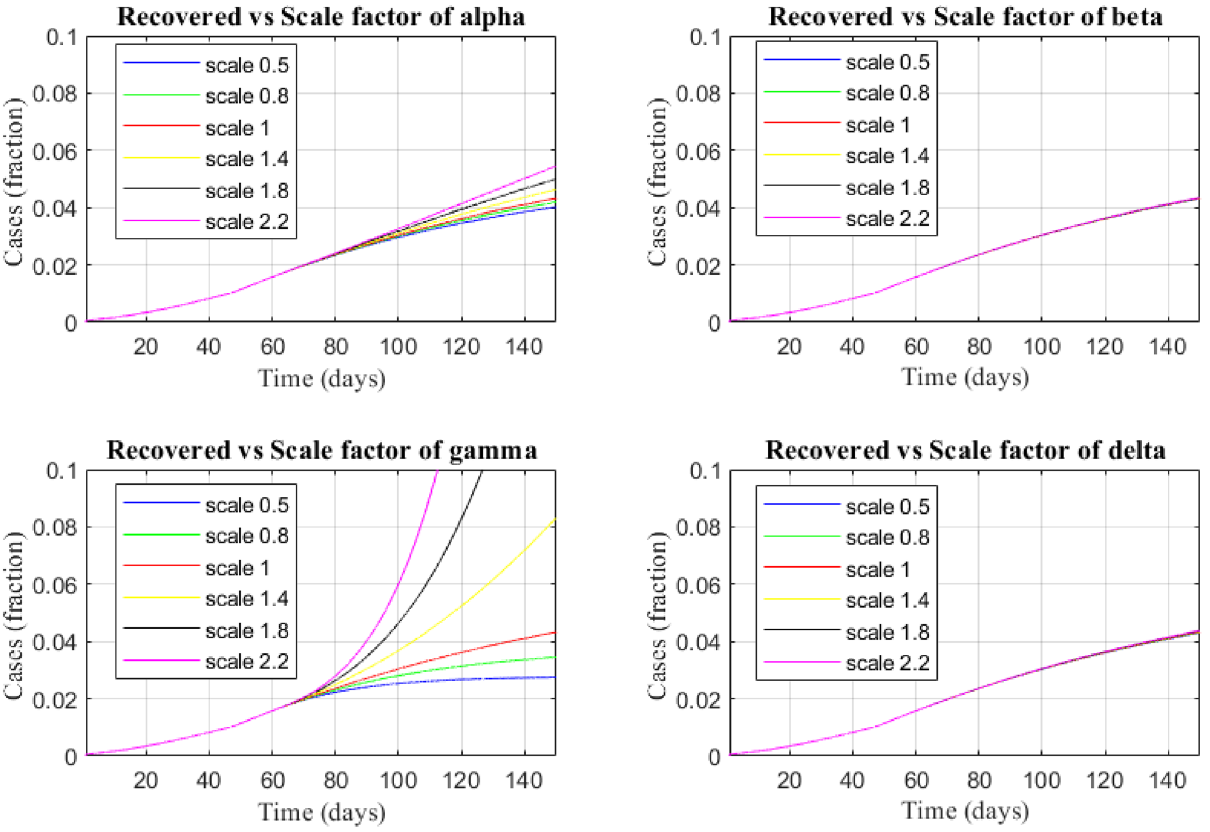
Figure 9. The sensitivity of transmission parameters over recovered